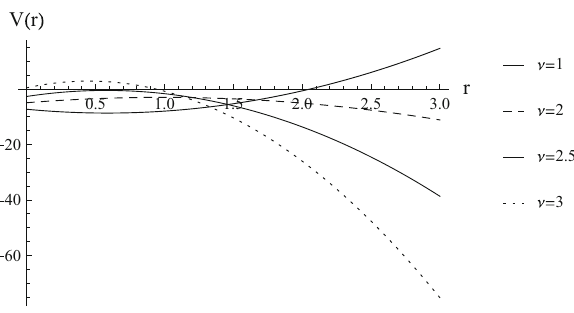
Fig. 1 The behavior of the effective potential V ( r ) for massless particles as a function of r for different values of ν with E = l = 1, r − = 1, r + = 2 and ν = 1 , 2 , 2 . 5 , 3. L = − 1 (left figure) and L = 1 (right figure)